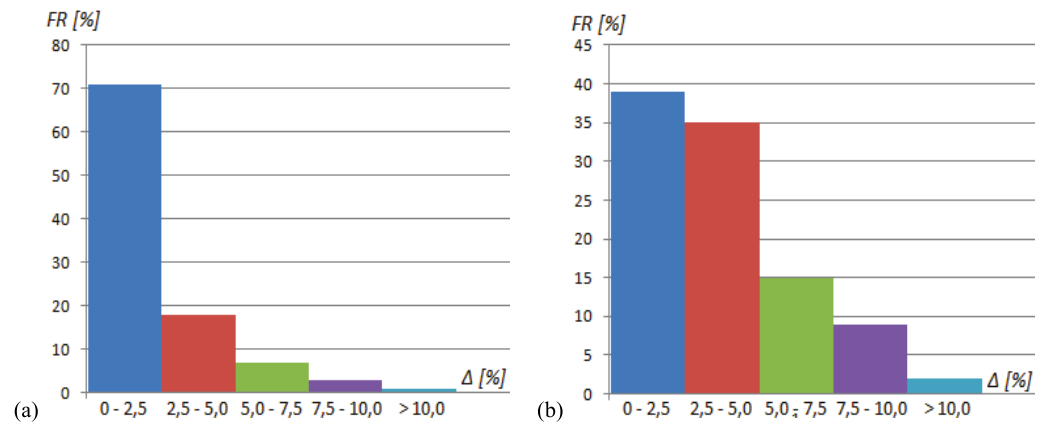
Fig. 11. Histograms of the relative error Δ : (a) training set, (b) testing